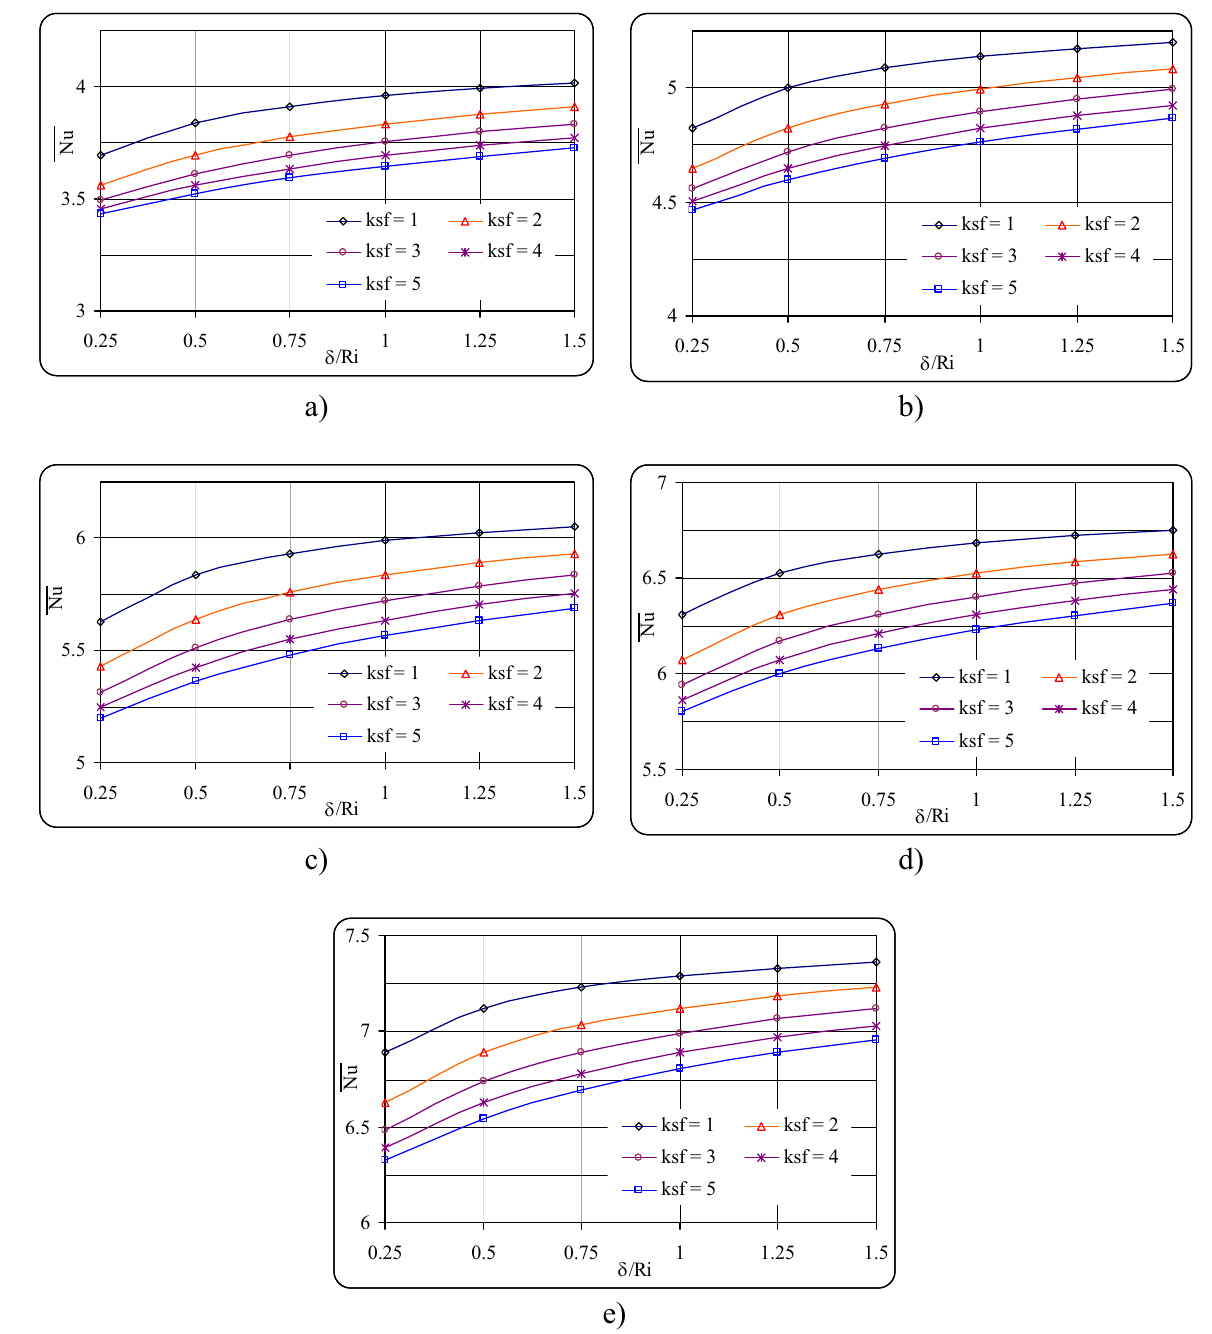
Figure 9: Average Nusselt number vs wall thickness to inside radius ratio with variable ksf ratio. ( a ) Re = 200, ( b ) Re = 400, ( c ) Re = 600, ( d ) Re = 800, and ( e ) Re =